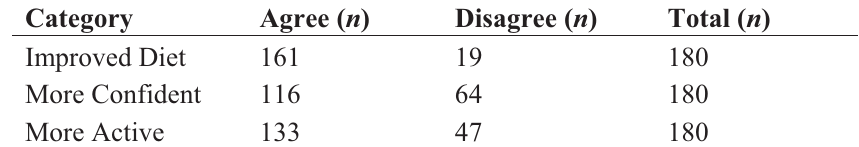
Table 7. Number of respondents having made lifestyle changes.